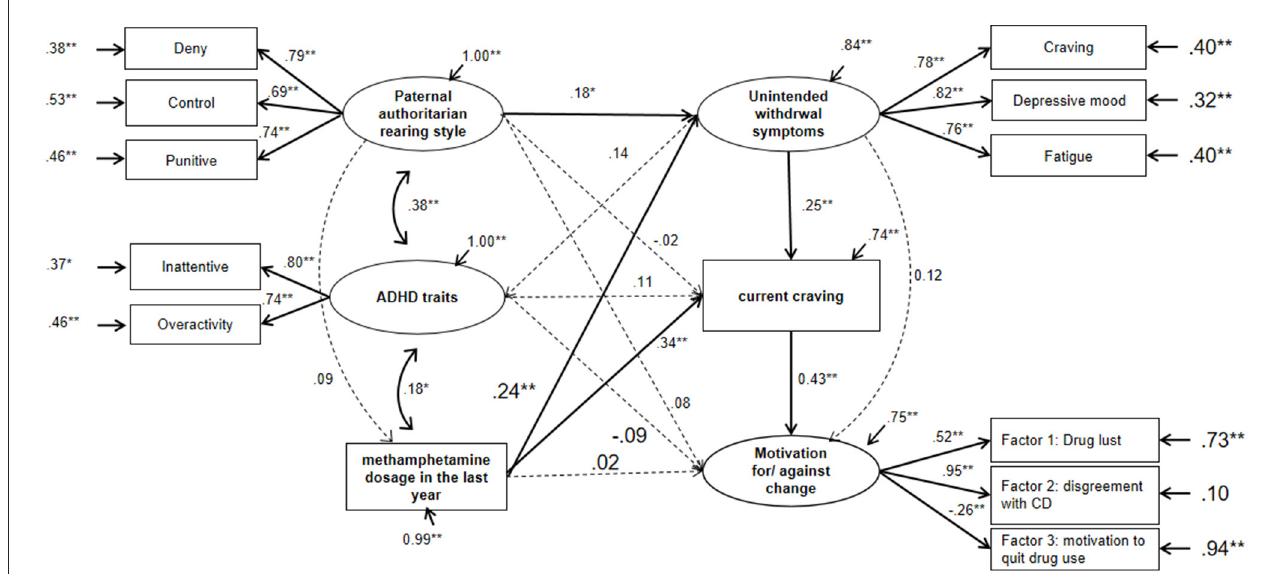
FIGURE4 Calculated structural model of the influence factors for motivations for/against change. The statistics shown were the standardized parameters. For the purpose of clarity, the coefficients with a P -value of below 0.05 were displayed in solid lines, while those not reaching statistical significance were displayed in dotted lines. ** P < 0.01, * P < 0.05, for the linear coefficients and